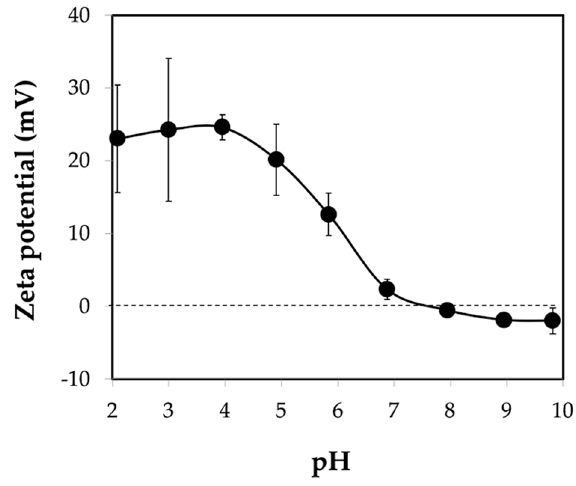
Figure 10. Zeta potential of chitin microgels prepared under conditions of 3 % w / w chitin solution, O:W = 15:1, 5% w / w Span 80 (HLB 4.3), and gelation by using 800 µ L of 1.0 M HCl.